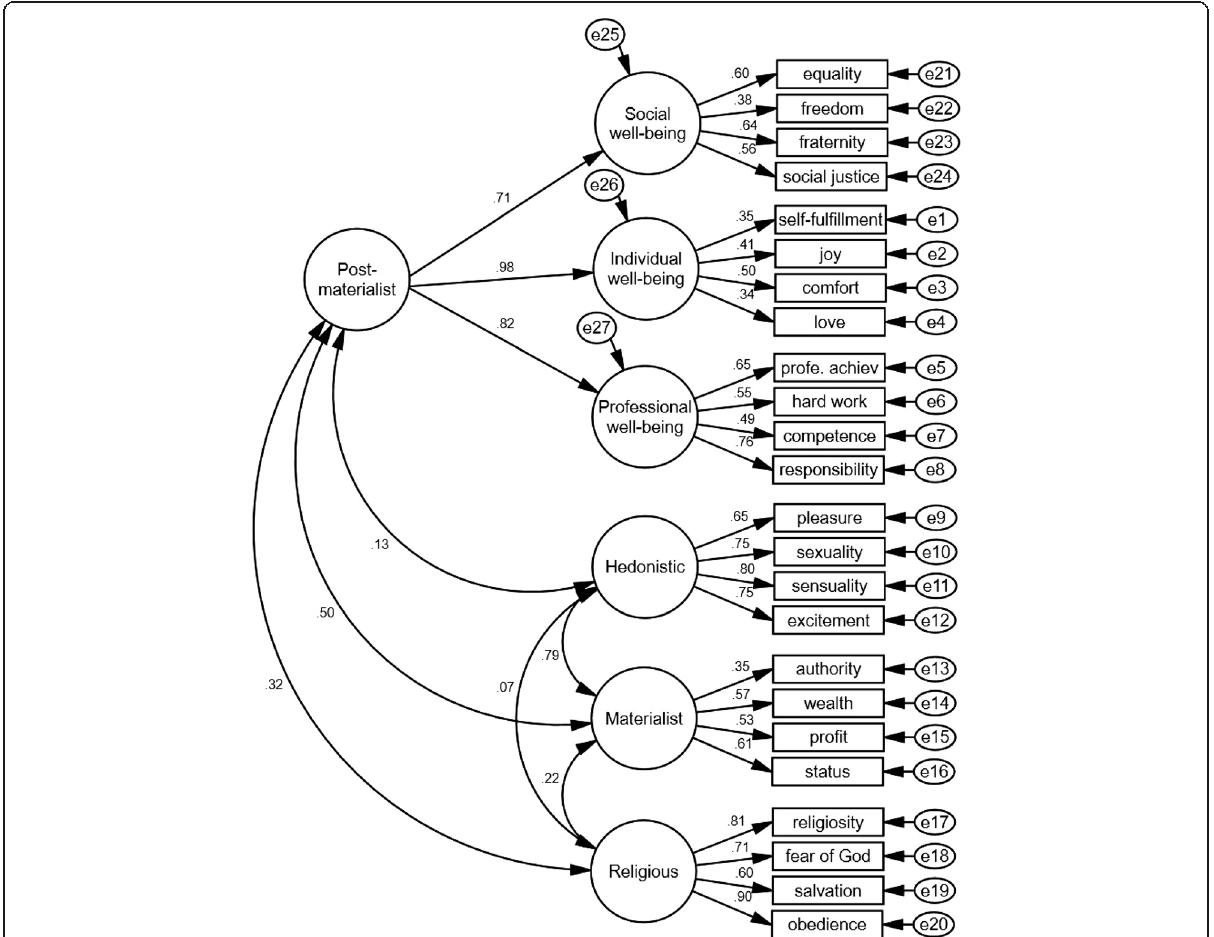
Fig. 3 Factor structure of the Psychosocial Values Questionnaire